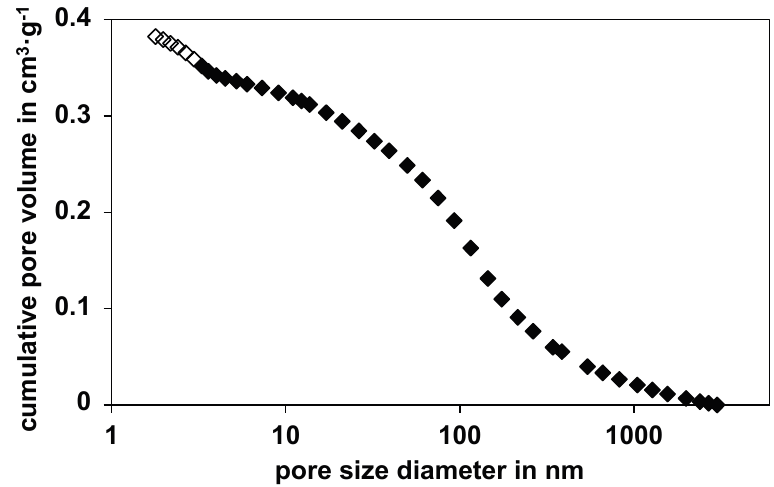
Figure 1. Cumulative pore volume of the nickel catalyst against the pore diameter based on the BET analysis (white rhombi) and the mercury-porosity measurement (black rhombi) Data from [8].